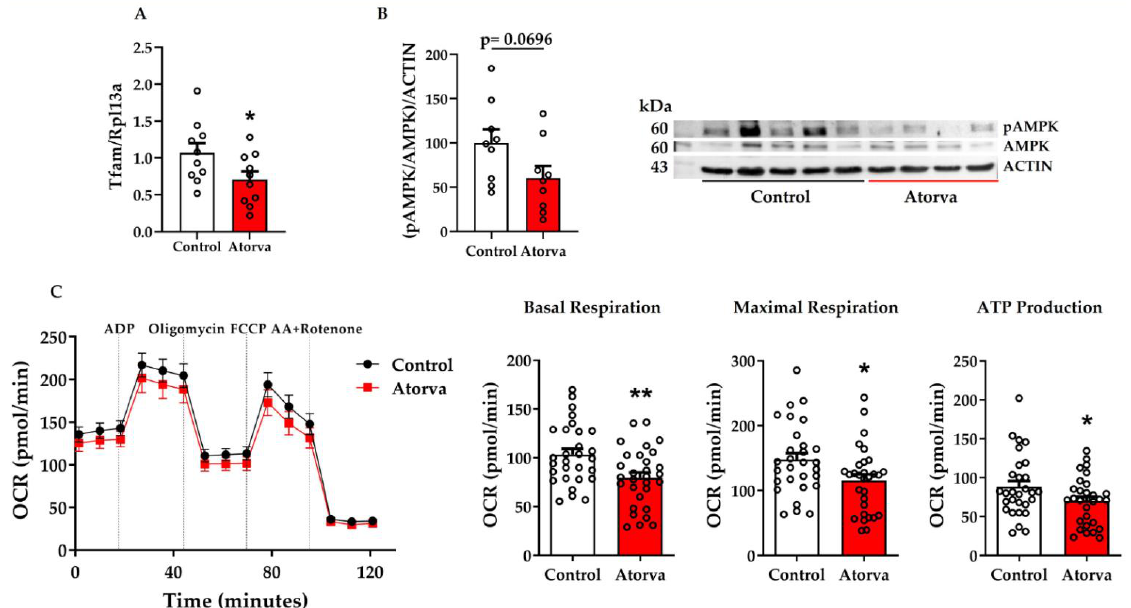
Figure 3. Evaluation of gene expression of Tfam ( A ) and representative Western blot pertaining protein expression of pAMPK/AMPK/ACTIN ( B ) in quadriceps. Rpl13a was used as a housekeeping for the gene expression ( A ) and actin was used as a housekeeping for proteins ( B ). Oxygen consumption rate was assessed in mitochondria of skeletal muscles of ApoE -/- mice fed HFHC and HFHC plus atorvastatin ( C ). Skeletal muscles were a pool of tibialis anterior, extensor digitorum longus, soleus, gastrocnemius, quadriceps, and biceps brachii. Between-group differences were assessed by Student’s t -test. * p < 0.05; ** p < 0.01. Data are expressed as mean ± SEM. ADP, adenosine triphosphate; AA, antimycin A; FCCP, carbonyl cyanide- p -trifluoromethoxyphenyl-hydrazone; HFHC, high-fat high- cholesterol diet; OCR, oxygen consumption rate; Tfam, mitochondrial transcription factor; AMPK, serine/threonine kinase AMP-activated protein kinase. n = 9 in each group ( A , B ); n = 6 in each group ( C ). Control = high-fat high-cholesterol diet; Atorva = high-fat high-cholesterol diet plus atorvastatin. kDa, kilodalton; SEM, standard error of the